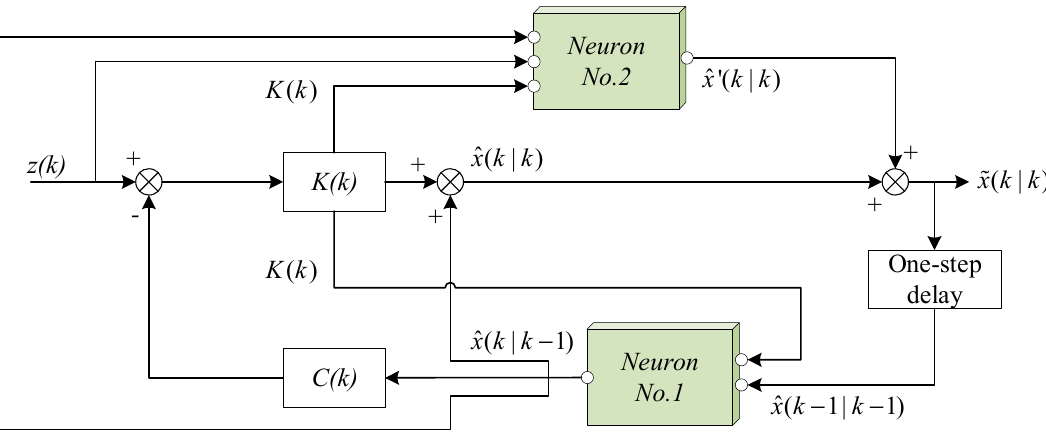
Figure 1. Framework structure of the neuron-based Kalman filter.